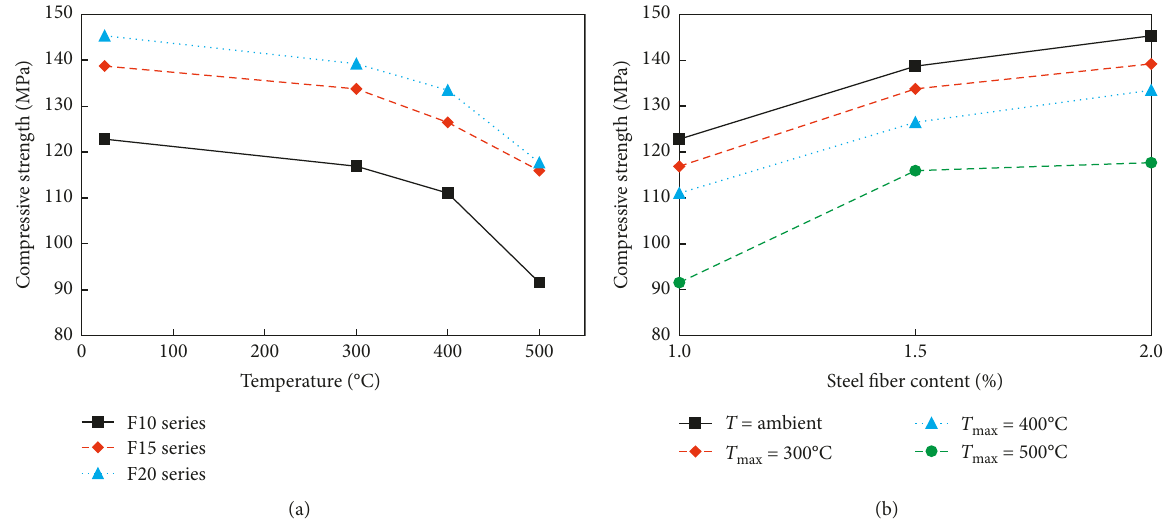
Figure 5: Compressive strength test results. (a) Relationship between the compressive strength and the maximum temperature. (b) Relationship between the compressive strength and the steel fiber content.